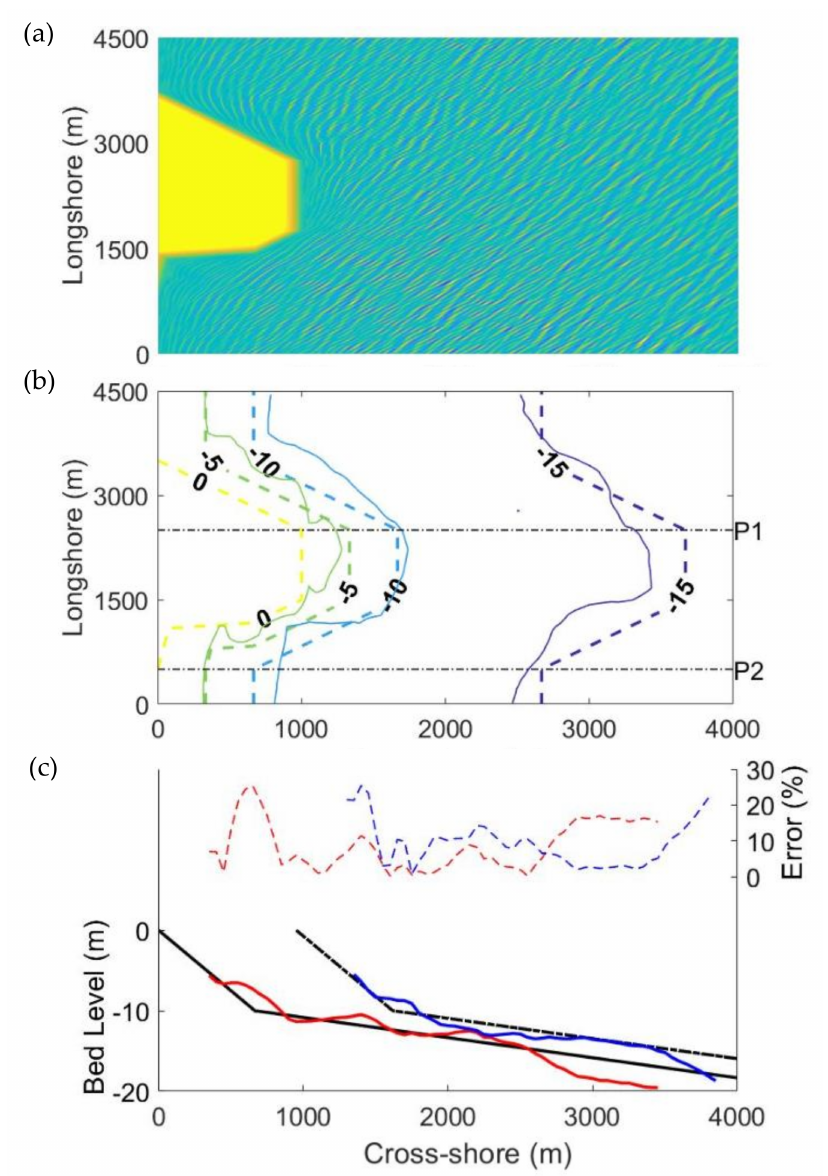
Figure 8. Irregular waves propagating to a headland at oblique incidence: ( a ) generated image representing the two-dimensional wave propagation at the surface; ( b ) isobaths of the calculated bathymetry over the real bathymetry; ( c ) cross-shore profiles P1 and P2 (real—black lines; estimation using wavelets—red and blue lines) and respective relative errors. FUNWAVE numerical simulations performed with H s = 2 m, T p = 10 s, θ = 30 ◦ , and dx = 1 m. Total simulation time was 2500